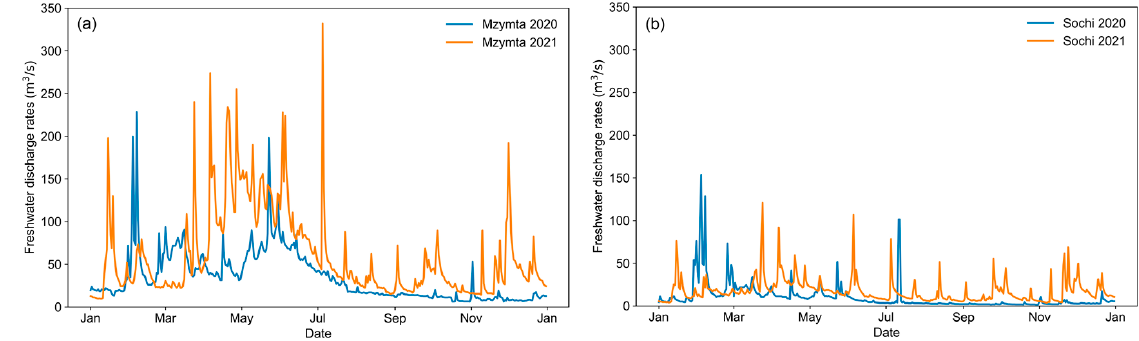
Figure 2. Freshwater discharge rates of the Mzymta ( a ) and Sochi ( b ) rivers during 2020–2021. Floods were detected in the following way: their average daily discharge peak had to exceed earlier discharge by 2–2.5 times (with respect to a previous 1-day reference period) and exceed the long-term average monthly discharge (~30 years) in order to discard very low floods or discharge fluctuations. Snowmelt freshets and rain-induced floods were determined by taking into account the average daily air temperature and the amount of precipitation measured at the Sochi and Adler meteorological stations. Separation